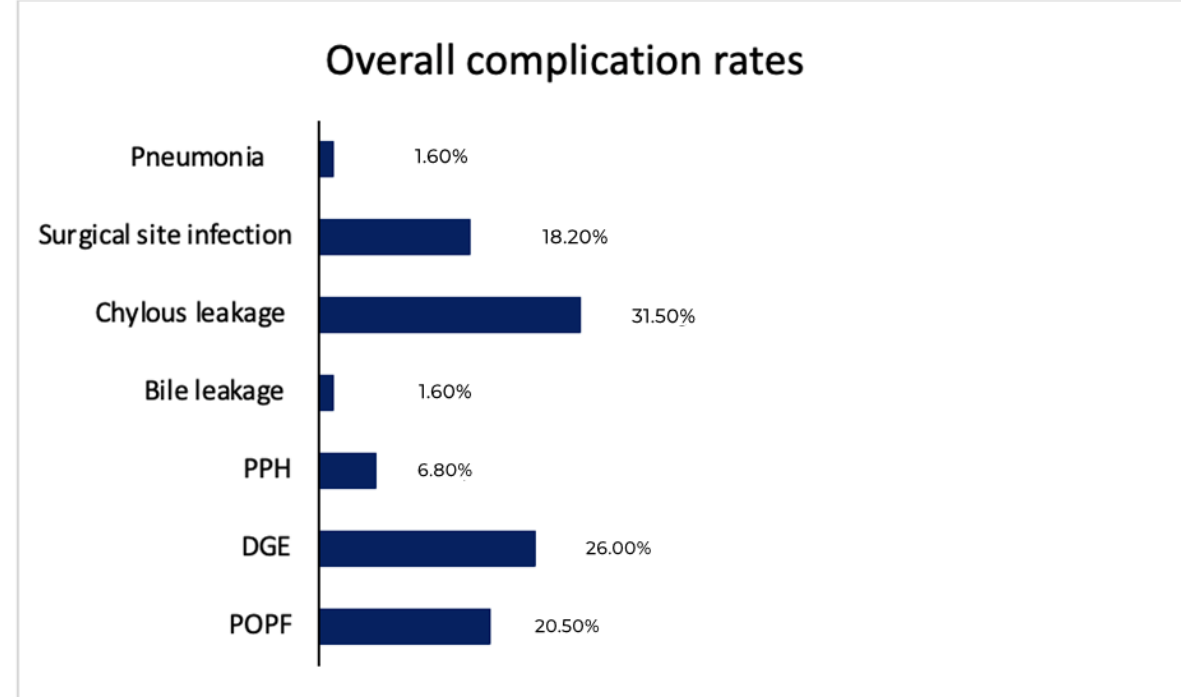
Figure 2. Overall morbidity and their rates in the validation cohort ( n = 308) patients.